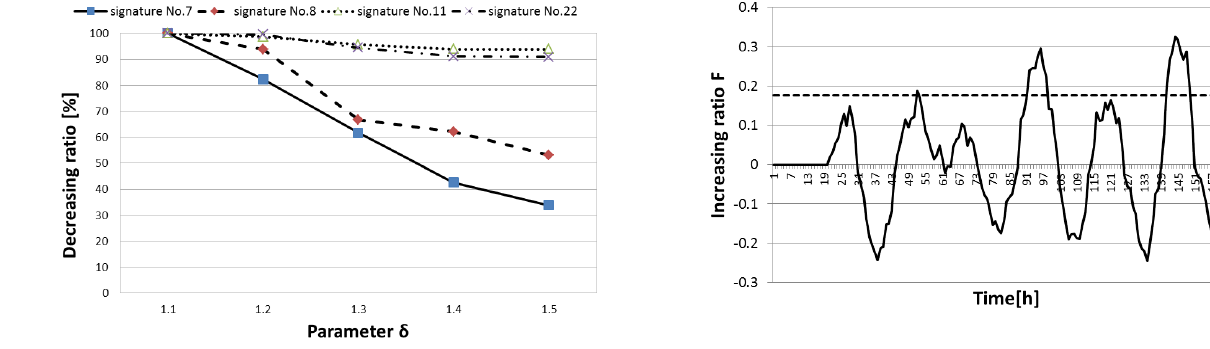
Figure 11: Increasing ratio F of the number of de- tections for signature number 8.